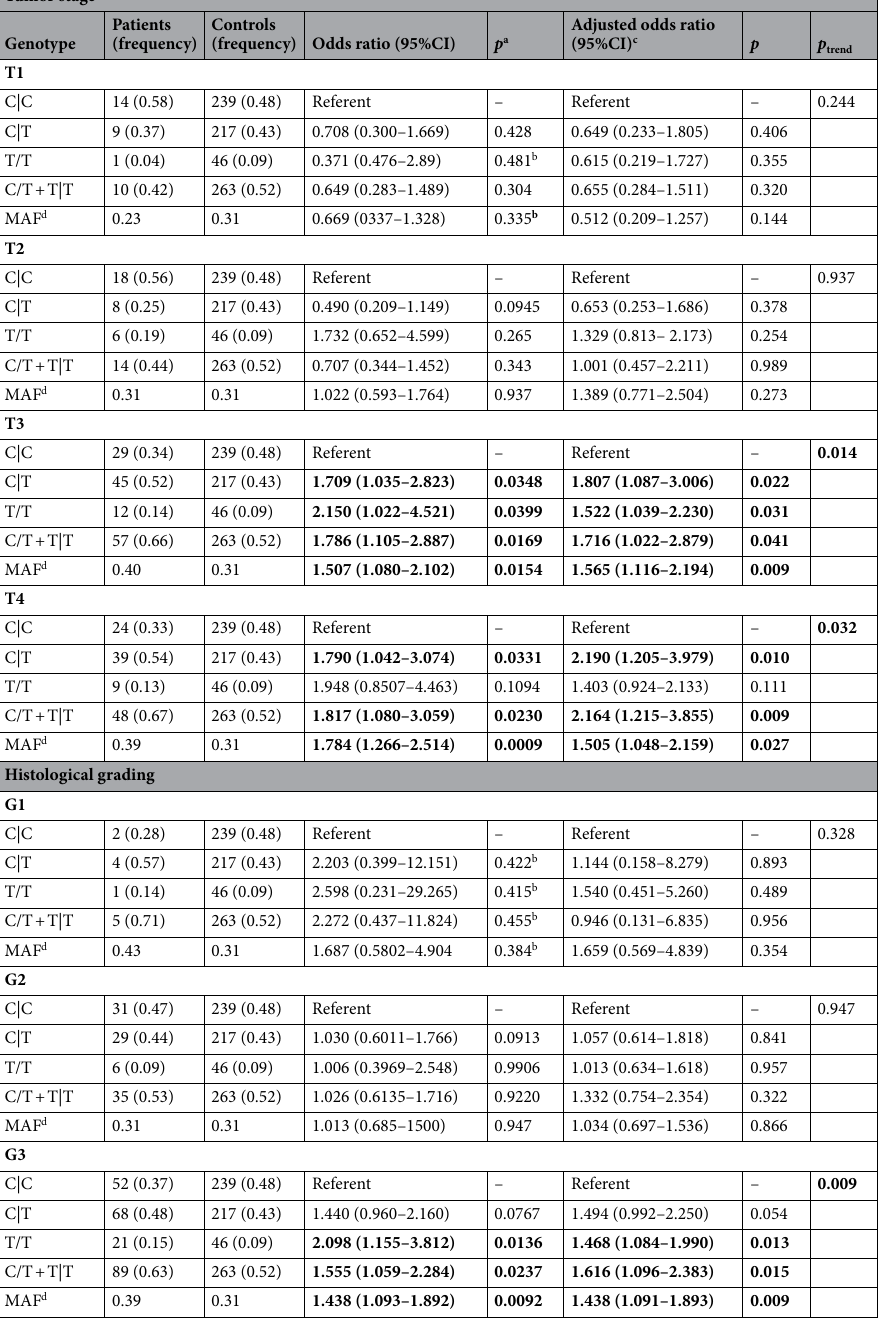
Table 4. Prevalence of the CCAT1 rs67085638 polymorphism among various tumour stages and differentiation grades of GC. Significant results are highlighted in bold font. a χ 2 or b Fisher’s exact test. c ORs were adjusted by age, BMI and presence of diabetes. d Minor allele